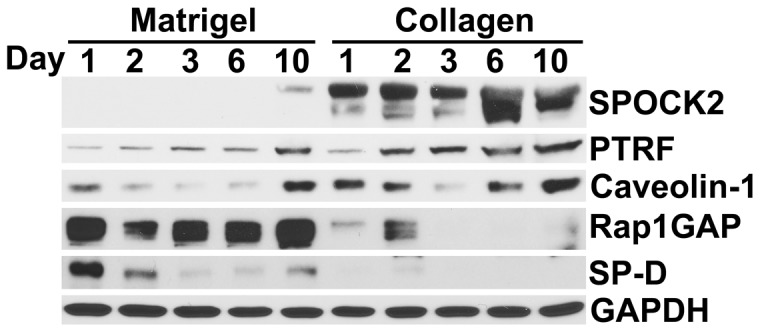
Time course protein expression analysis of selected candidate genes.SPOCK2 and PTRF/CAVIN-1 proteins increase in transitioning hAT2 cells on collagen over 10 days, while Rap1GAP is expressed mainly in AT2 cells on Matrigel. AT1 signature caveolin-1 and AT2 signature SP-D are shown to confirm phenotype. Freshly-isolated hAT2 cells were seeded on rat-tail collagen or Matrigel; cells were harvested for proteins on days 1, 2, 3, 6 and 10 after seeding. Results shown are representative of three separate time course experiments using cells from two isolations.